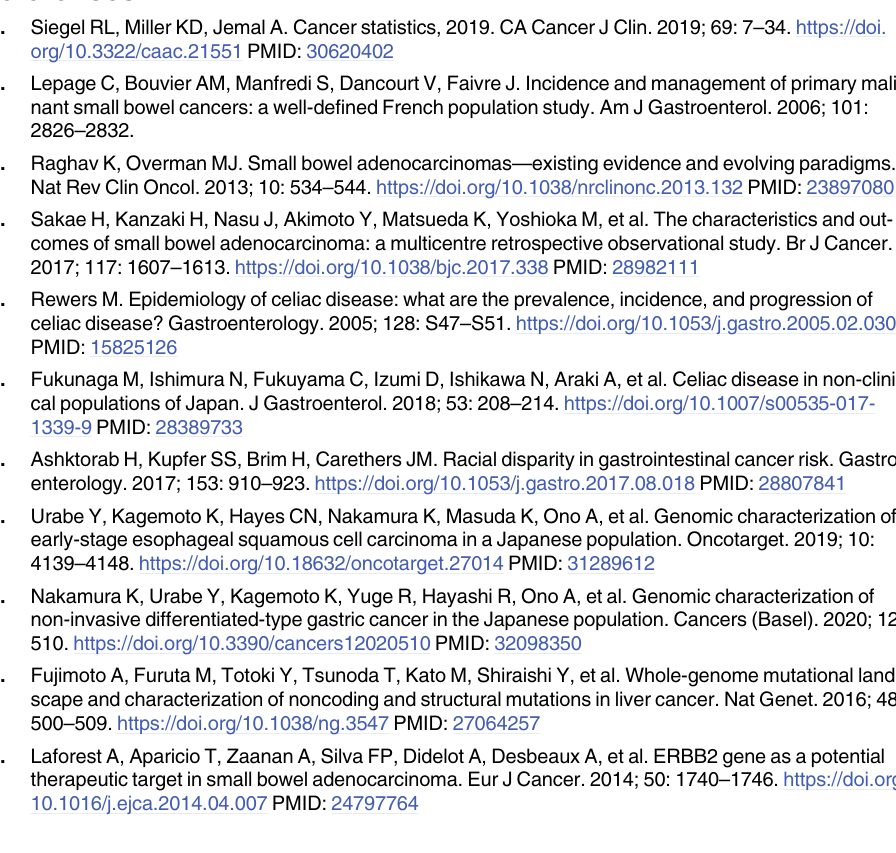
S4 Fig. Comparison of common mutated gene frequency of small-bowel cancers between the current study and previous studies. We compared the frequency of genomic variants in TP53 , KRAS , APC , SMAD4 , and PIK3CA for small-bowel cancers. There were no significantly different genomic variants for any gene. However, the frequency of genomic variant of APC and PIK3CA in this study tended to be higher than that reported in previous studies. S1 Table. Target panel of 90 cancer-related genes used in our study. S2 Table. Outcome of immunohistochemistry analysis. S3 Table. Characteristics of lesions with high TMB and low